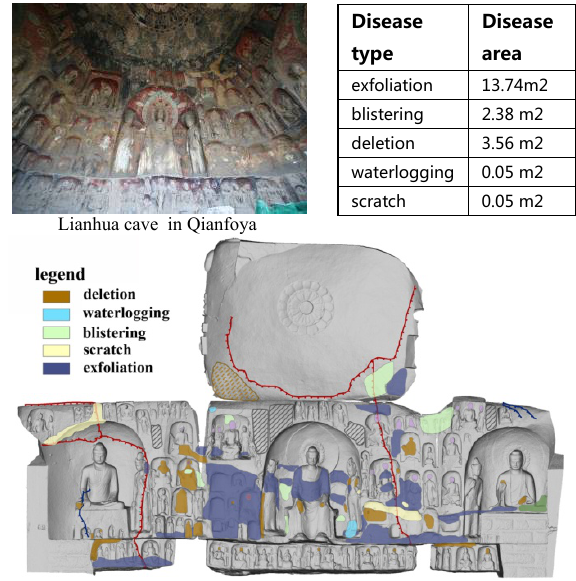
Fig.3 Distribution of disease in lianhua cave